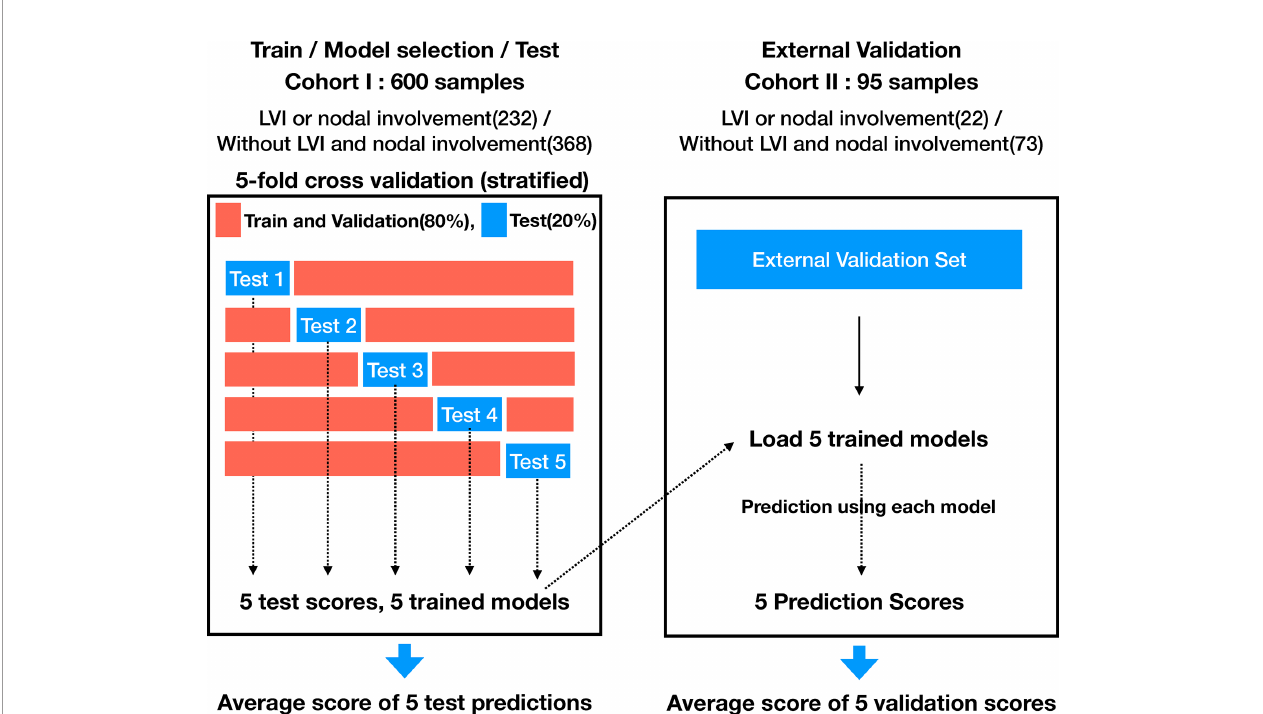
FIGURE 2 | Evaluation pipeline for proposed